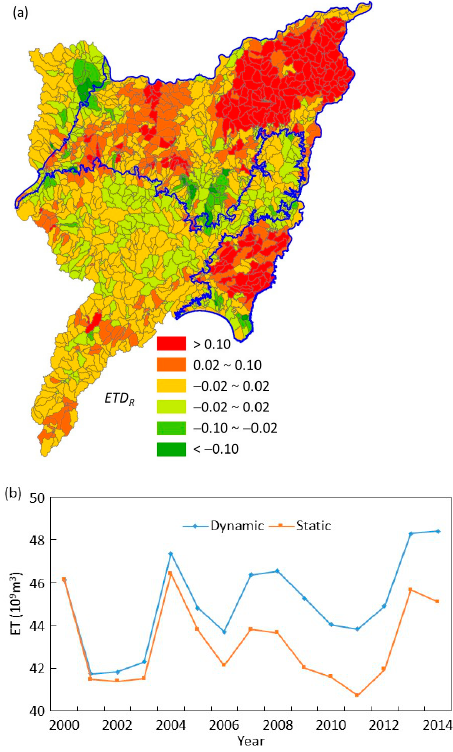
Figure 11. Spatial and temporal differences in evapotranspiration (ET) between the dynamic mode and the static mode from 2000 to 2014. ( a ) The relative difference in the average annual ET (ETD R ) on the sub-watershed scale and ( b ) a comparison of annual ET processes in the whole region.